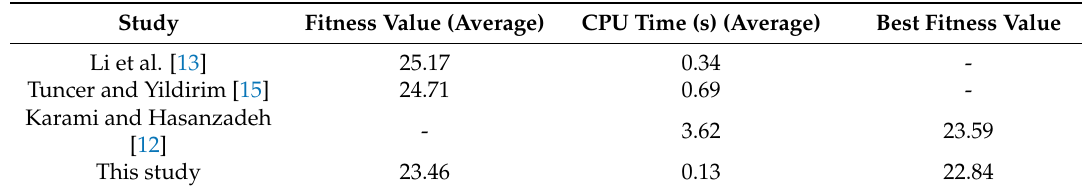
Table 2. Comparison of results in Environment